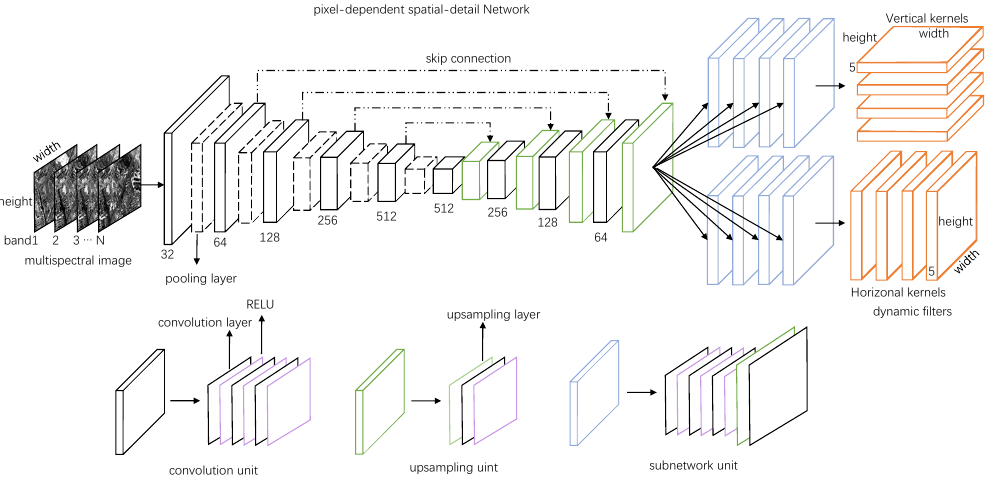
Figure 2. The structure of PDSDNet, which inputs four bands MS and outputs filters for simulating